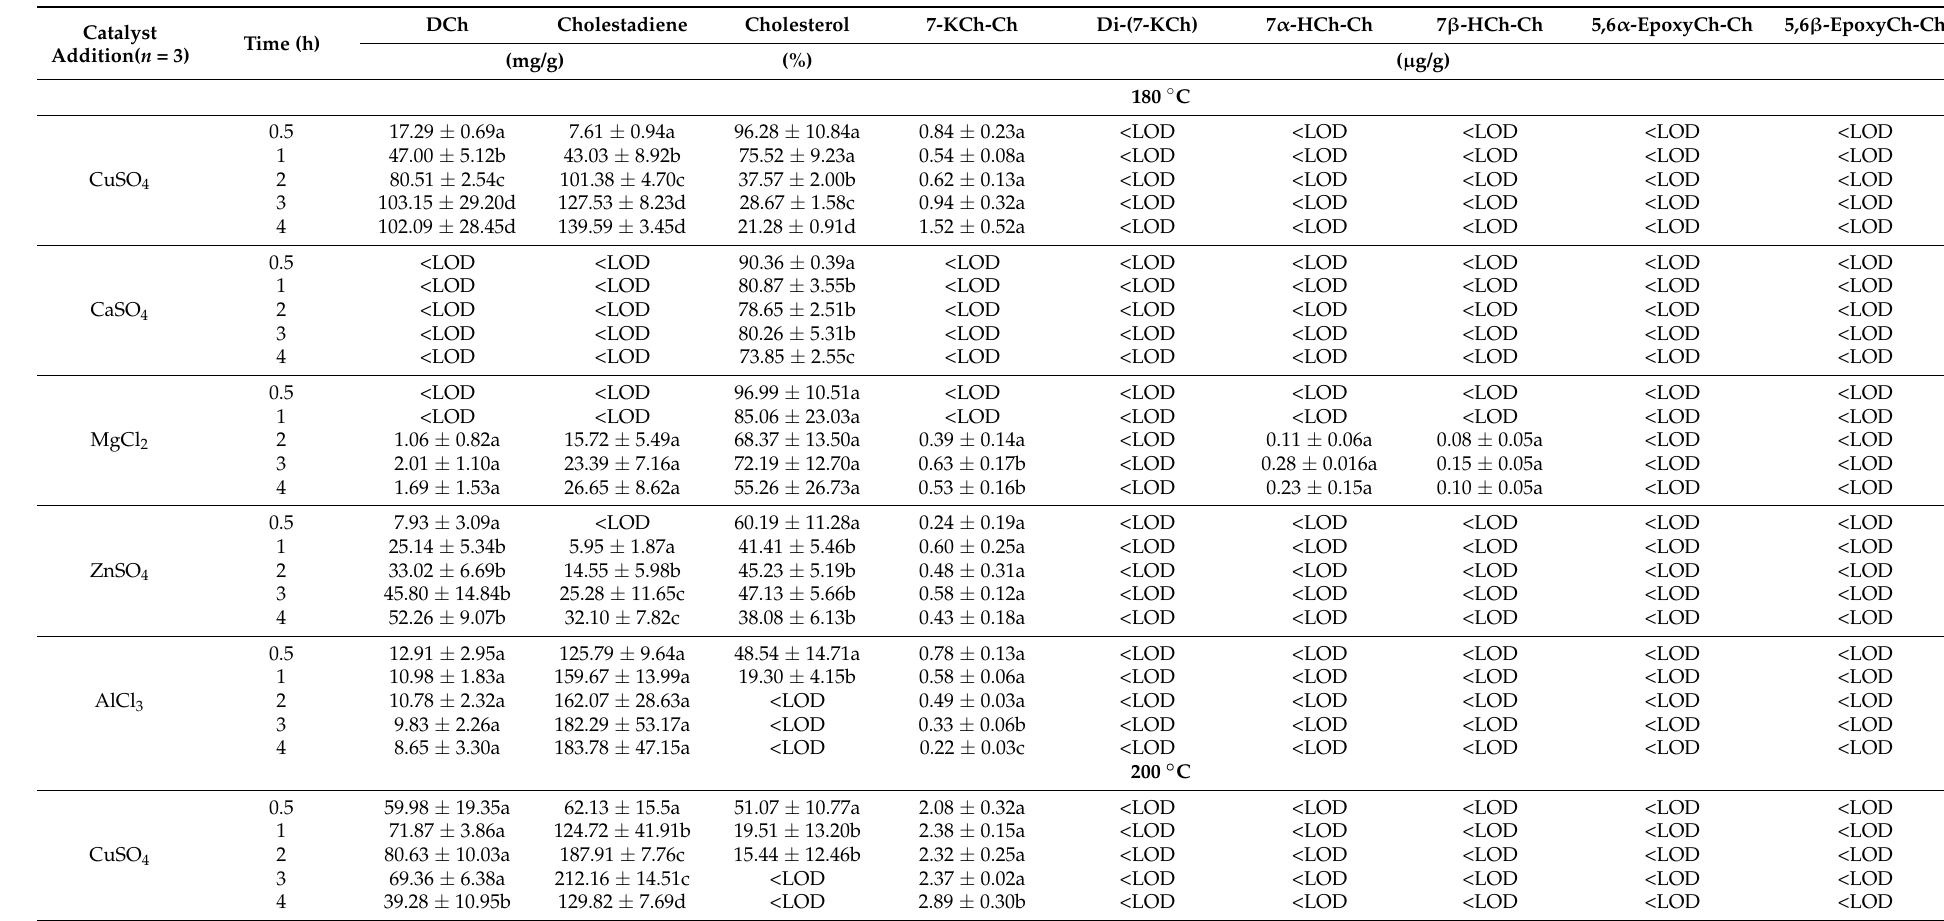
Table 1. Measured content of 3 β ,3 (cid:48) β -dicholesteryl ether, cholesta-3,5-diene and oxidized 3 β ,3 (cid:48) β -dicholesteryl ethers in cholesterol samples with inorganic salts after heating at different temperatures and